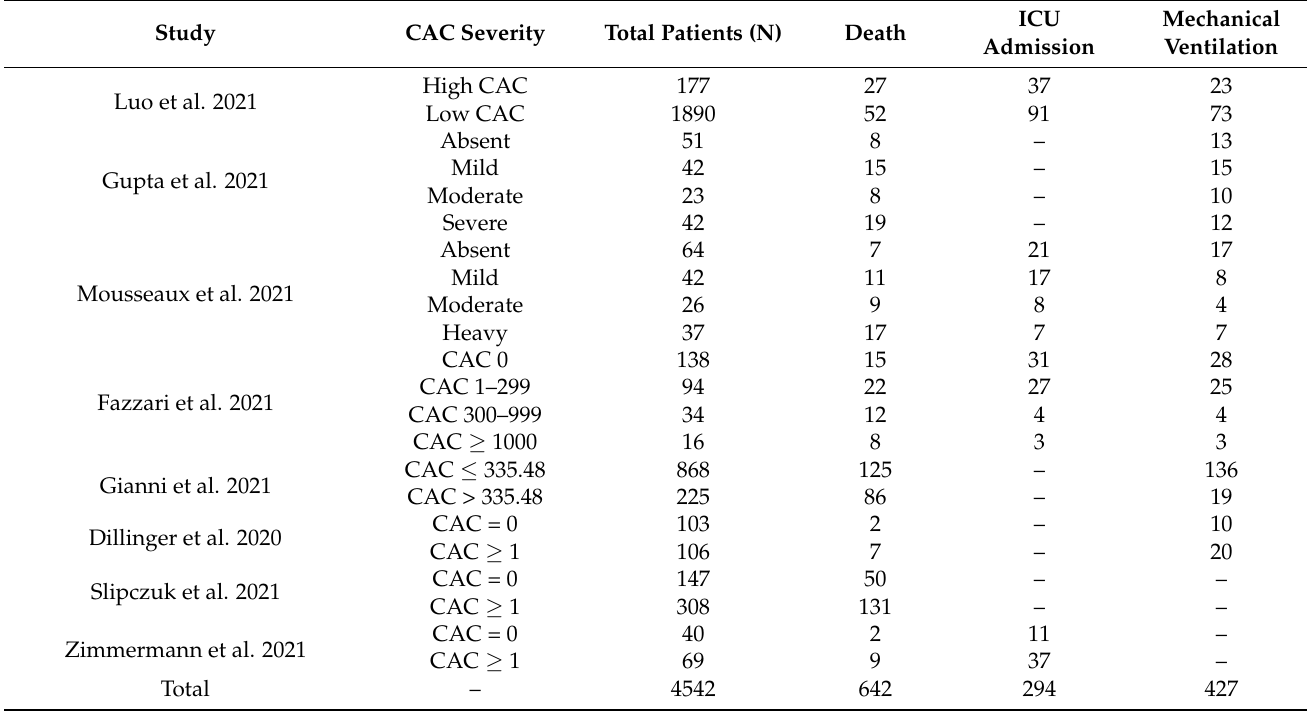
Table 2. Individualized data of each